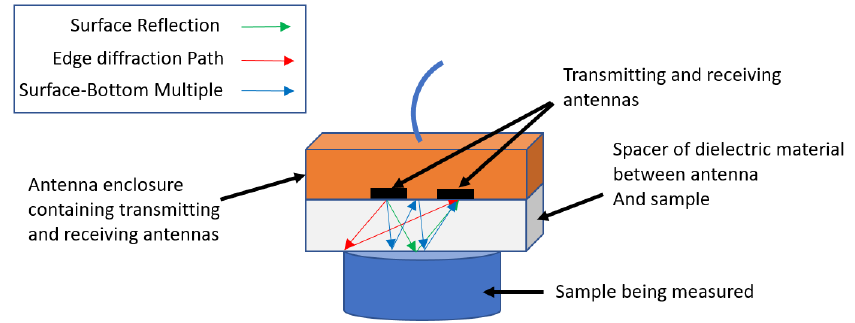
Figure 5. Cut-away view showing the ray paths indicating sources of major reflections and diffractions arriving from surface of sample being measured.